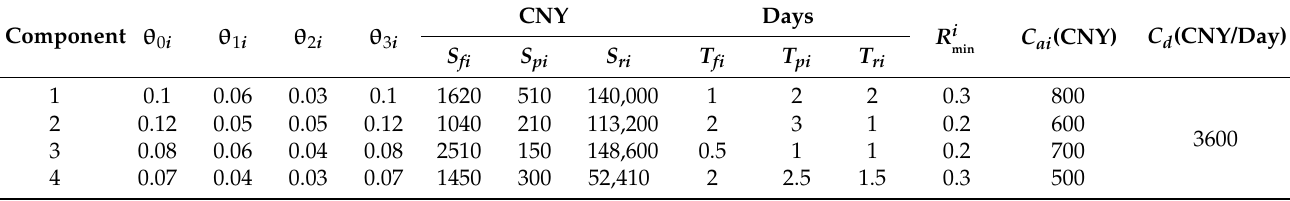
Table 3. Parameter